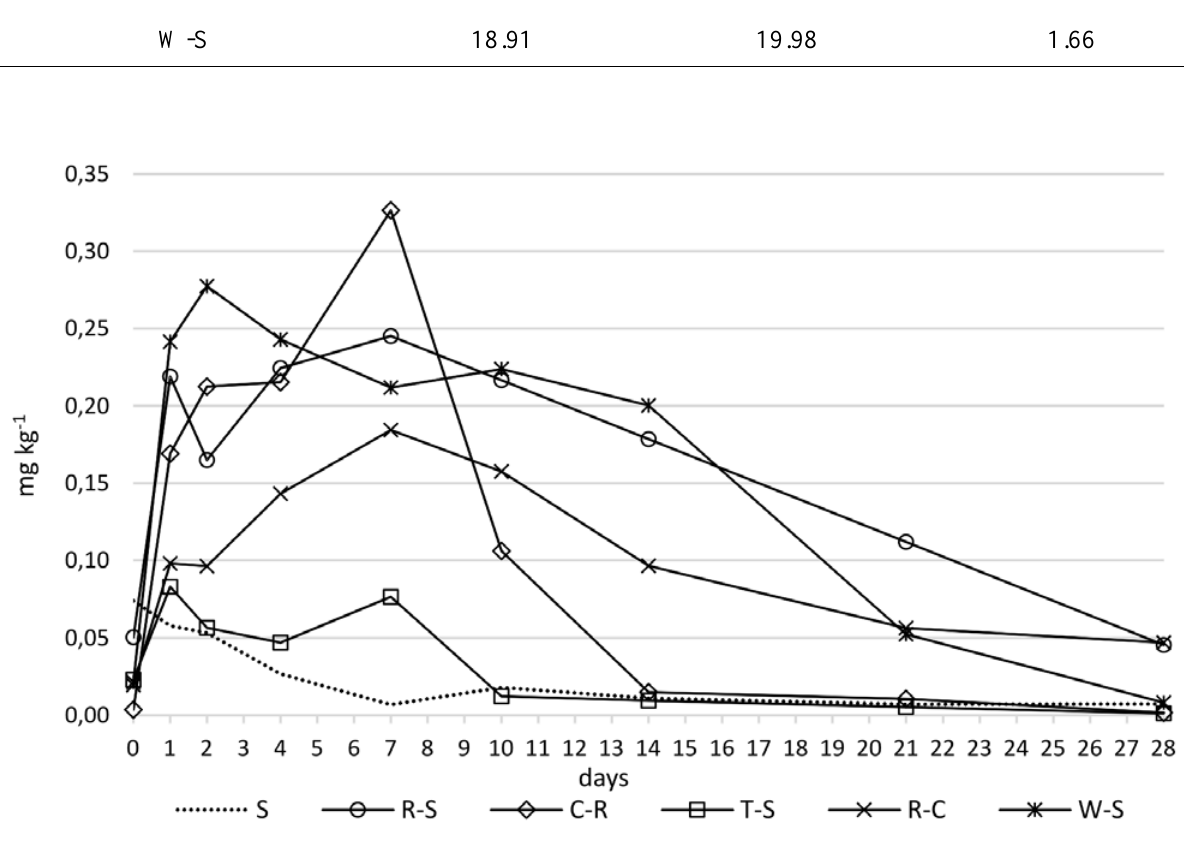
Figure 5. Daily production of nitrous oxide (expressed as N 2 O-N) from the amended soils. Amendments: R-S = Reed sweet-grass digestate, C-R = Common reed digestate, T-S = Tufted sedge digestate, R-C = Reed canary grass digestate, W-S = Woollyfruit sedge digestate, S = unamended